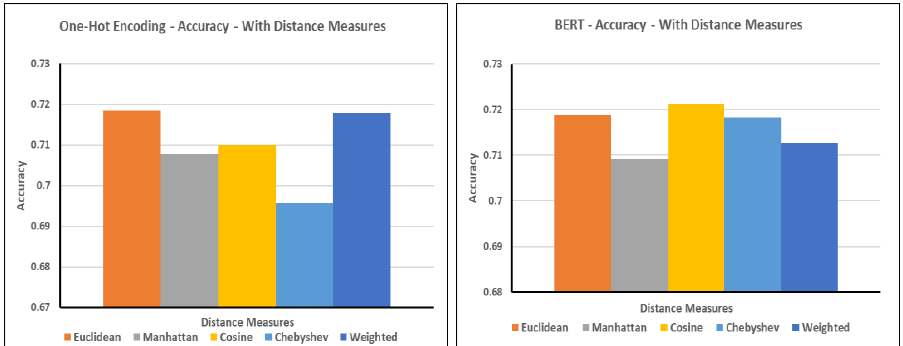
Figure 5. Accuracy with various distance measures (one-hot encoding and BERT).